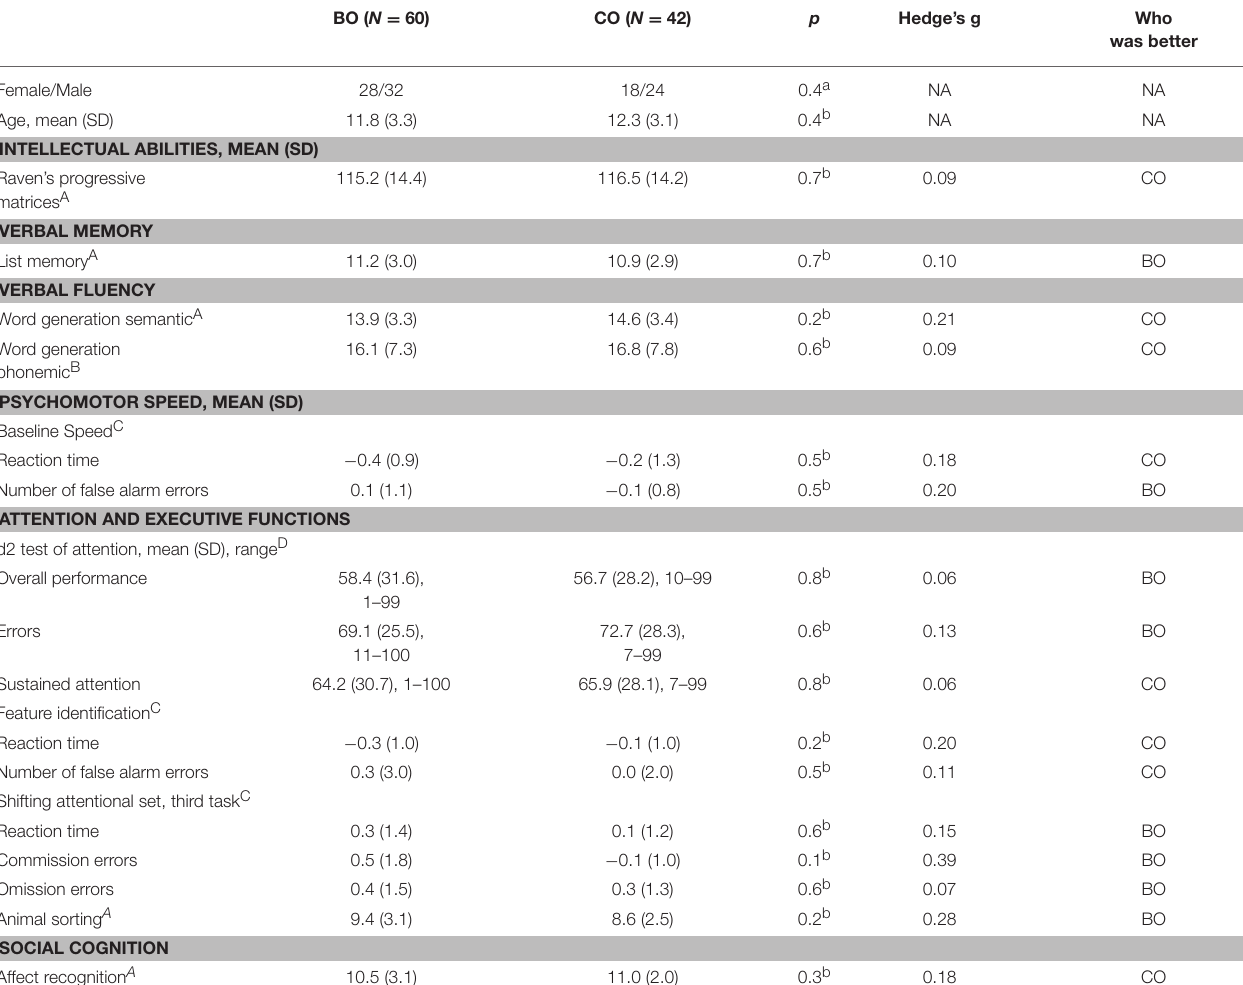
TABLE 3 | Neuropsychological characteristics of the BO and CO groups. BO ( N = 60) CO ( N = 42) p Hedge’s g Who